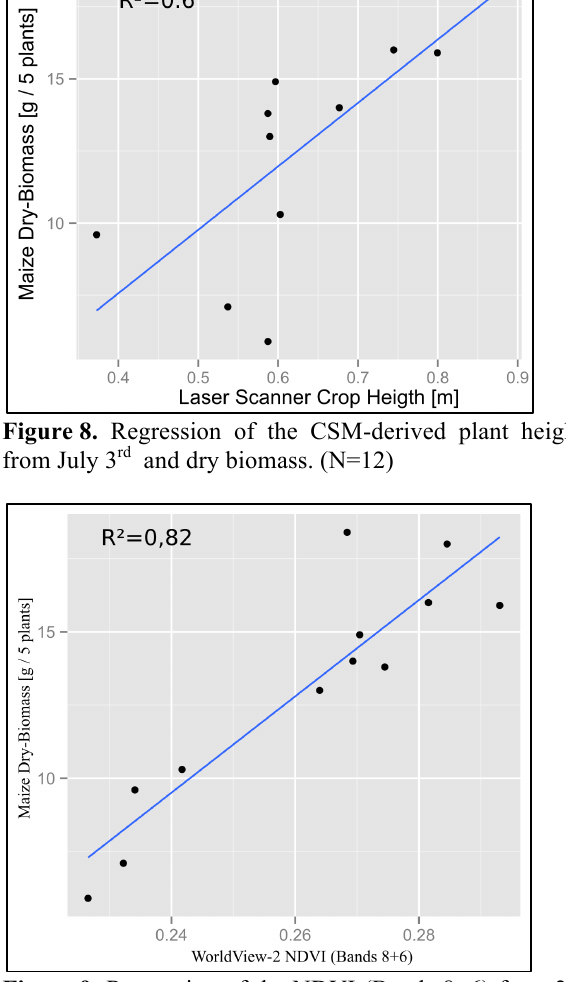
Figure 9. Regression of the NDVI (Bands 8+6) from 2 nd WorldView-2 acquisition from the 6 th July and the dry biomass taken on 3 rd July (N=12).